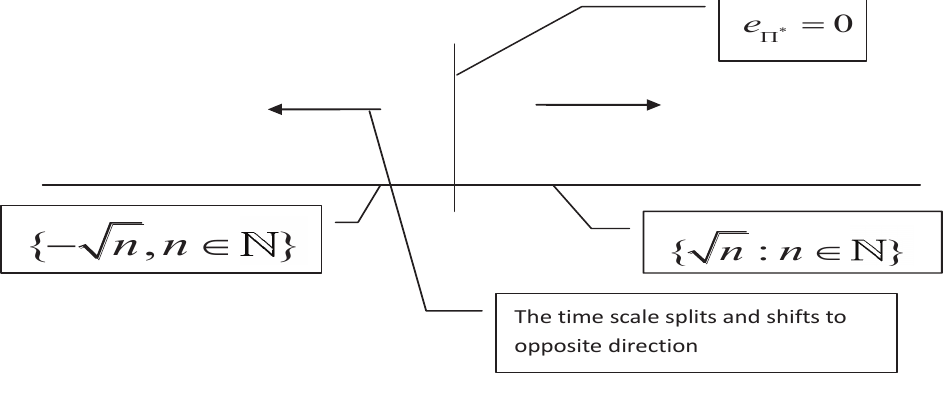
Figure 4. The time scale T = ± N 1 2 has the characteristic point e Π ∗ = 0 at which the shift δ τ ( · ) is discontinuous. This time scale splits at t = 0 and has the opposite shift closedness at the split